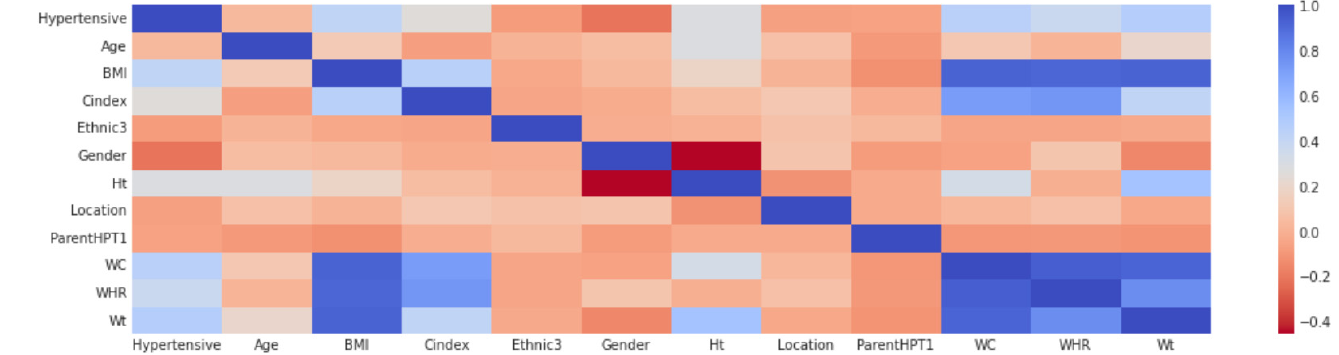
Figure 2. Heatmap showing the dependency of the 11 features in the study: hypertensive, age, BMI, C Index (Cindex), ethnicity (Ethinic3), gender, height (Ht), location, parental hypertension (ParentHPT1), waist circumference (WC), weight-to-height ratio (WHR) and weight (Wt). Table 3. Correlation coefficients of BMI with WC, WHtR and weight (Wt).